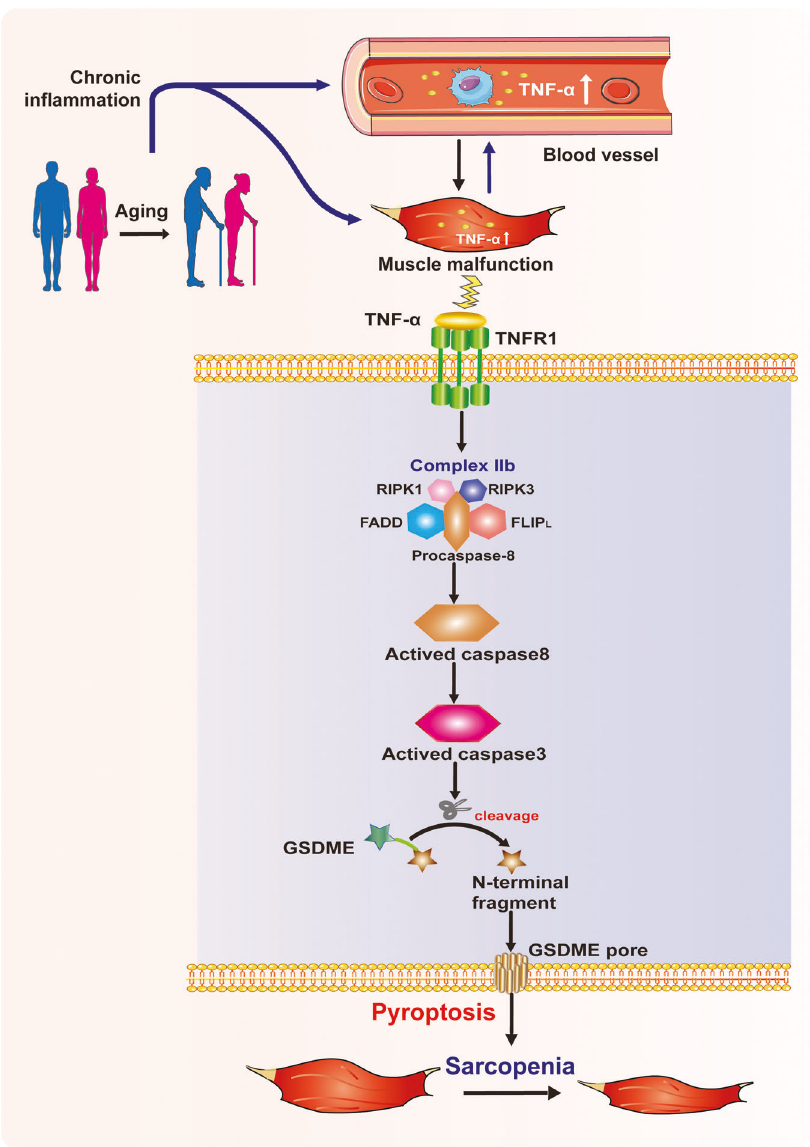
Fig. 8 Model of TNF- α -induced sarcopenia by regulating caspase-8/caspase-3/GSDME-mediated pyroptosis through TNF Complex IIb. Aging leads to a chronic low-grade in fl ammation represented by the high level of serum TNF- α and local TNF- α overexpression in skeletal muscle. TNF- α binds to its receptor tumor necrosis factor receptor 1 (TNFR1) to assemble TNF Complex IIb on muscle cell surface. The assembly of TNF Complex IIb activates caspase-8 and downstream caspase-3. Activated caspase-3 further cleaves GSDME to release N-terminal fragment of GSDME. The intracytoplasmic N-terminal domain transfers to the membrane and forms pores in the cell membrane, executing pyroptosis in muscle cells. pyroptotic muscle cells result in loss of skeletal muscle fi bers and fi nally lead to